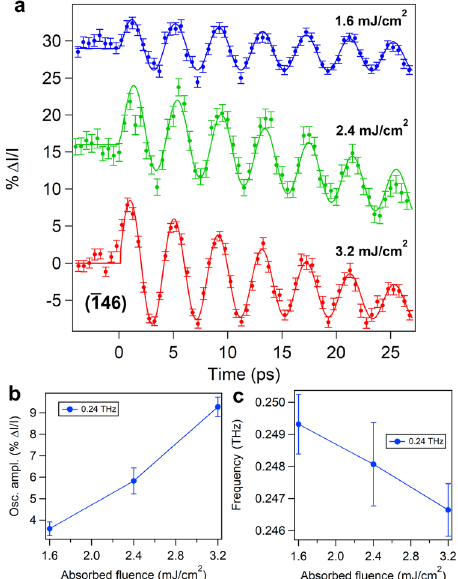
Fig. 2 Fluence dependence for the ð 146 Þ peak. a Experimental data and fi t curves, where the traces have been equally shifted for clarity; the oscillatory amplitude and frequency are reported in panels b and c . The error bars represent one standard deviation